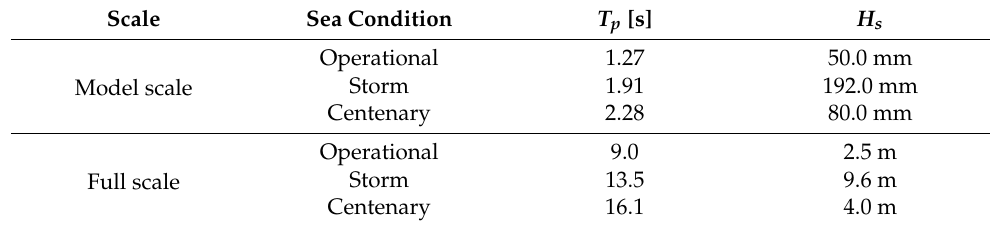
Table 11. Sea conditions characterized by an ISSC spectrum.